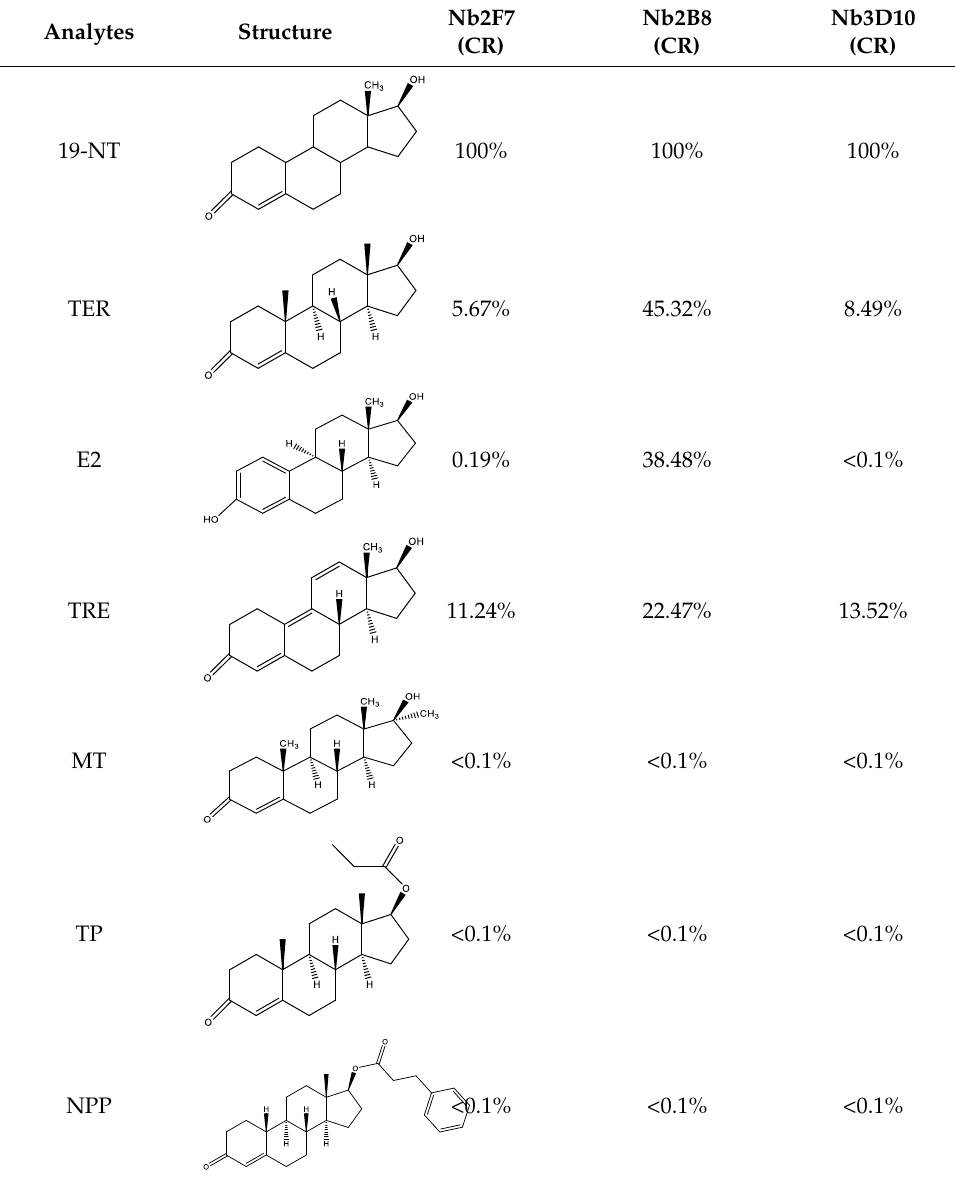
Figure 7. Standard curves of ic-ELISA based on Nb2F7, Nb2B8 and Nb3D10. Table 1. Cross-reactivity of Nbs with 19-NT structural analogues.